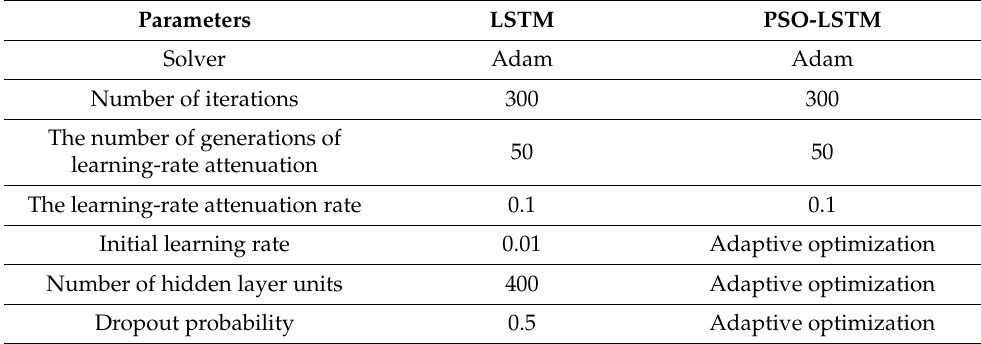
Table 5. Parameters of LSTM and